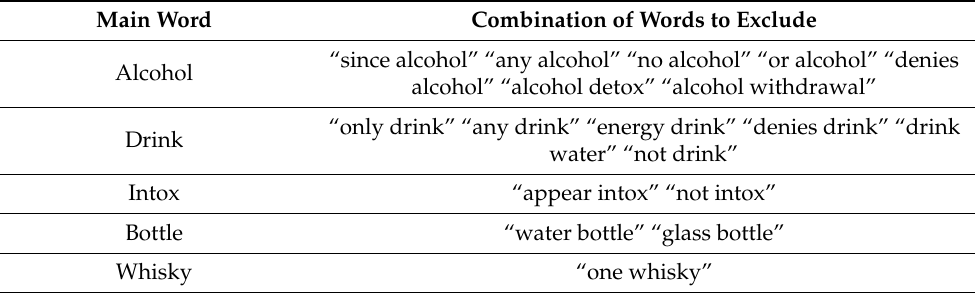
Table 1. Combination of words to remove from alcohol-related